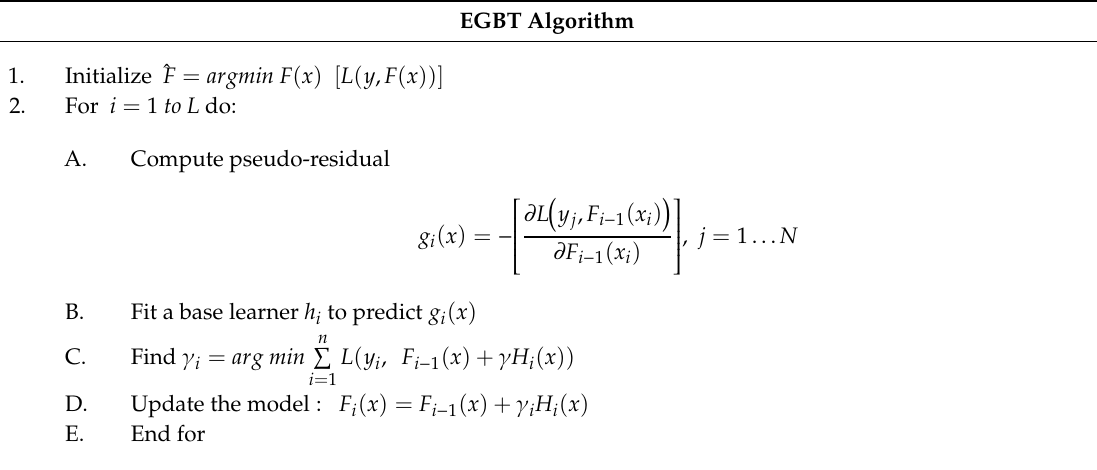
Table 4. Algorithm of the gradient boosted tree (GBT). EGBT Algorithm